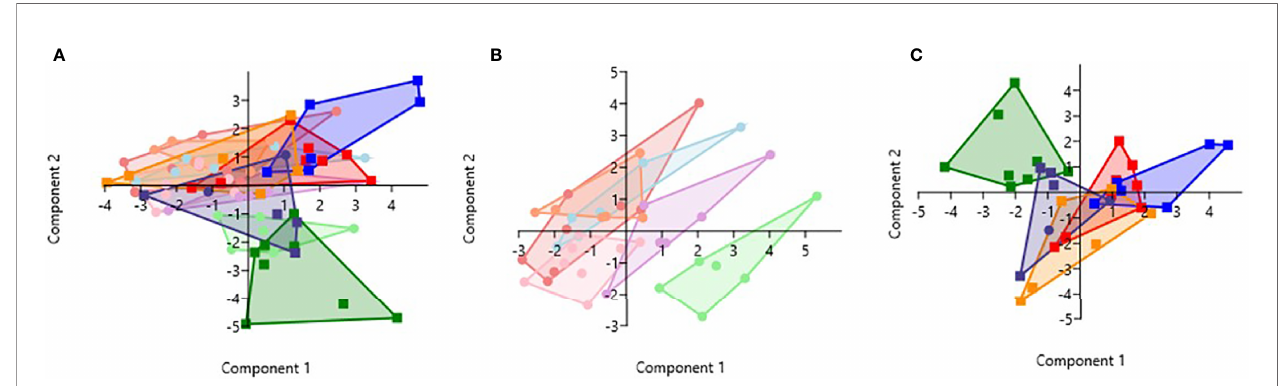
FIGURE 6 | Principal Component Analysis for cytokines (CXCL10, CCL2, TNF- a , CCL3, IL-8, IL-6) and CBC (WBC, RBC, Hb, and PLT). Principal Component Analysis was applied to cytokines (CXCL10, CCL2, TNF- a , CCL3, IL-8, IL-6) and CBC (WBC, HCT, Hb, and PLT) variables in Past 3.x (23). A correlation matrix was used since variables were measured in different units as well as between-group analysis. Missing data was replaced with column average using mean value imputation. Red is for HbAA-/+, orange is for HbAS-/+, blue is for HbAC-/+, purple is for HbSC-/+, green is for HbSS-/+, and pink is for HbCC-. Pastel color represents malaria negative and dark colors represent malaria positive groups. (A) Illustrates all genotypes with and without malaria. The PC1 and PC2 eigenvalue and percent variance are 4.9, 49% and 4.1, 40.6%, respectively. (B) Illustrates malaria negative genotypes only. PC1 and PC2 eigenvalue (5.82, 2.5) and percent variance (58.2, 25.3%), respectively. (C) Illustrates malaria positive genotypes only. PC1 eigenvalue and percent variance are 5.94 and 59.5%, respectively. PC2 eigenvalue and percent variance are 3.8 and 38.2%,